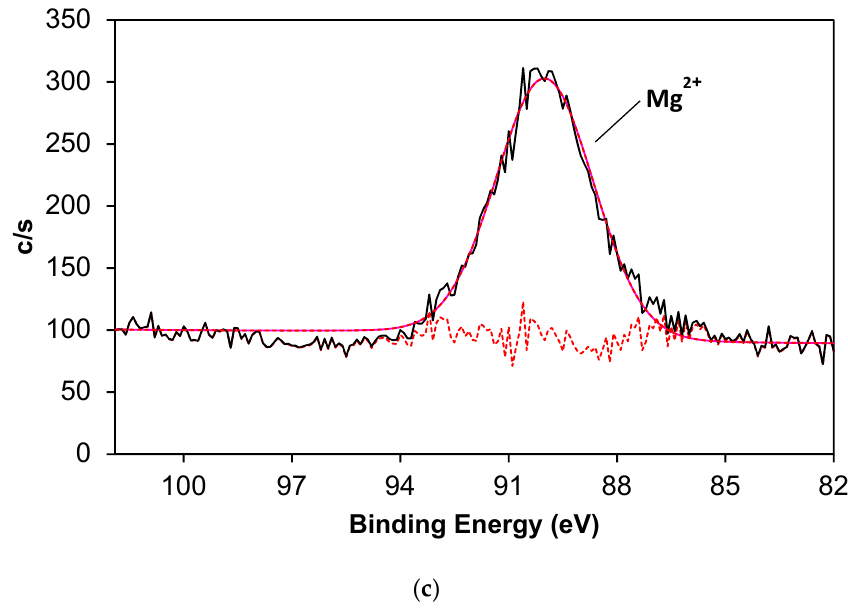
Figure 7. HR-XPS confirms the generation of a magnesium carboxylate after the EDP that decreases the surface tension of the as-prepared coating ( a ) C-1s, ( b ) O-1s and ( c ) Mg-2s.